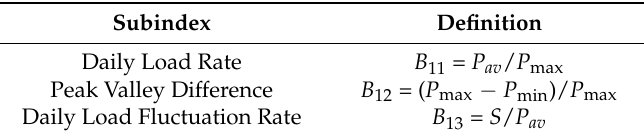
Table 3. Definition of output